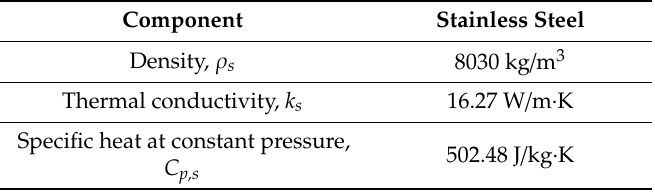
Table 1. Solid properties